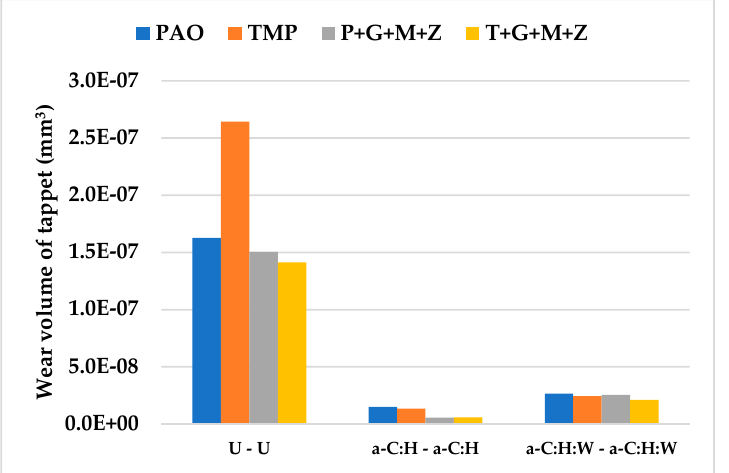
Figure 15. Wear volume of uncoated and DLC-coated tappets under various conditions with PAO- based and TMP-based lubricants.